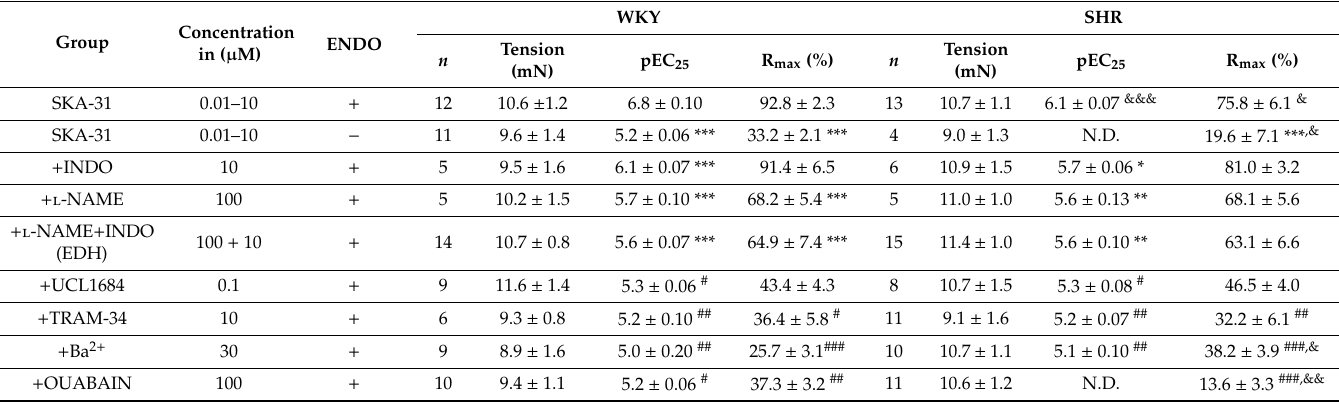
Data are expressed as mean ± SEM. n represents the number of animals. Results of relaxation are expressed as percentage of the isometric contraction induced by phenylephrine (10 µ M). SKA-31 (activator of